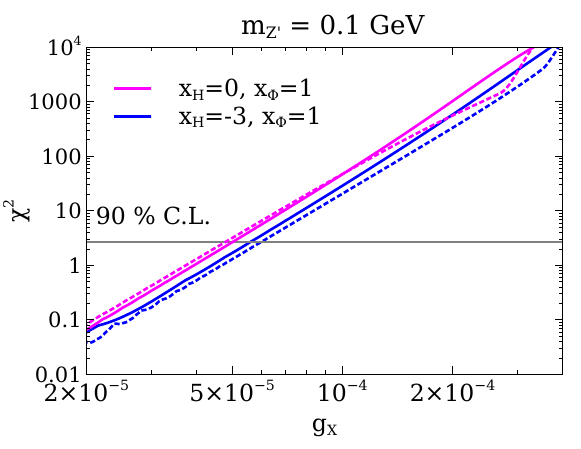
Figure 5 . χ 2 as a function of the coupling strength g X for neutrino (solid line) and anti-neutrino (dotted line) modes using the binned